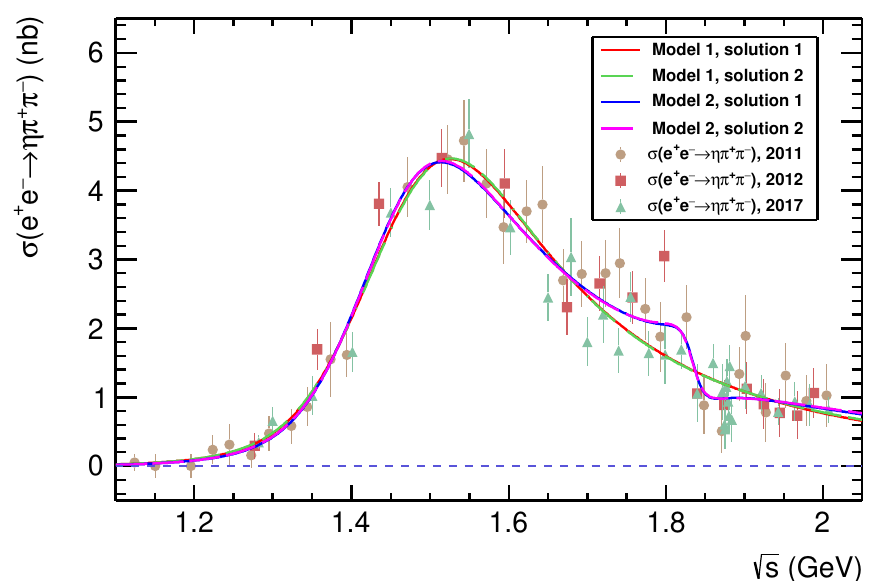
Figure 8 . The e + e (cid:0) ! (cid:17)(cid:25) + (cid:25) (cid:0) Born cross section (points with error bars) measured with the CMD-3 detector and (cid:12)tted with \Model 1, solution 1" (red solid curve), \Model 1, solution 2" (blue dashed curve), \Model 2, solution 1" (magenta solid curve) and \Model 2, solution 2" (green dashed curve). The \Model 1, solution 1" and \Model 1, solution 2" include contributions of (cid:26) (770) and (cid:26) (1450) and correspond to two di(cid:11)erent local minima of the (cid:12)t chi-square.